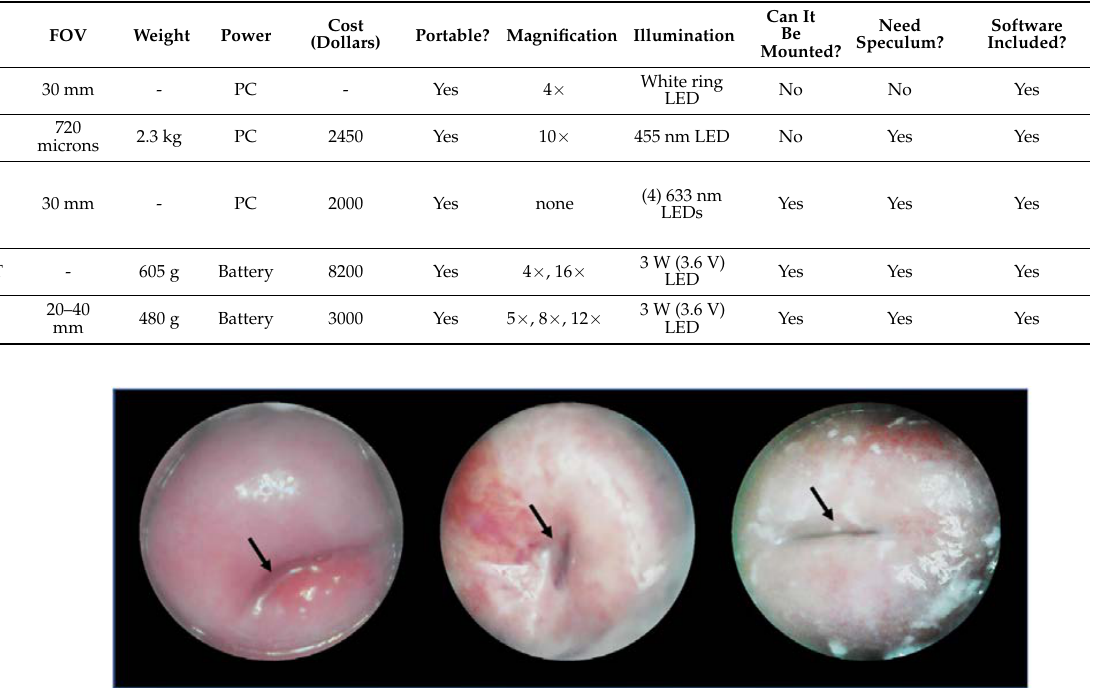
Figure 7. Sample images taken with the Callascope while self-imaging. The arrow points to the cervical external os (Reprinted from Ref. [40]).